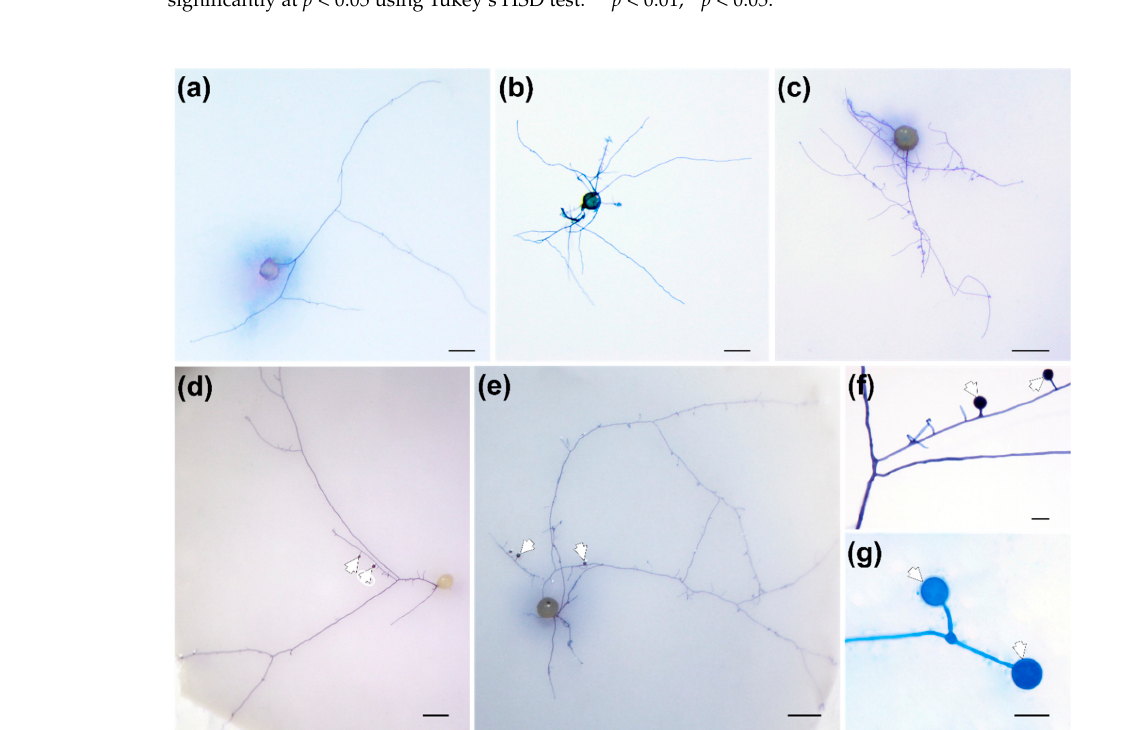
Figure 1. Effects of root exudates (RE) or root extracts (RET) on hyphal growth and differentiation of Funneliformis mosseae . Spores treated with sterilized water (control) ( a ), RE (1:50) ( b ), RE (1:5) ( c ), RET (1:50) ( d ) and RET (1:5) ( e ). Scale bars in ( a – e ) represent 200 µm. Solitary ( f ) and dichotomous ( g ) growth patterns of secondary spores (SS). Scale bars in ( f , g ) represent 20 µm. White arrowheads indicate SS.